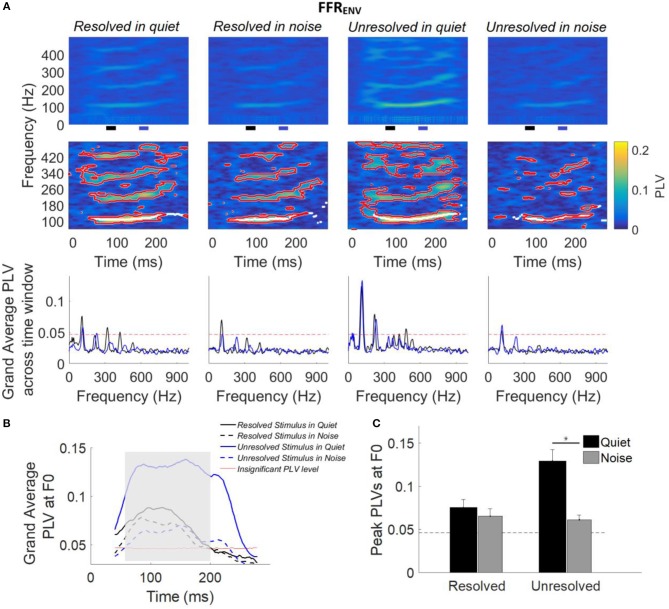
(A) Grand average FFRENV PLVs (top panels) and FFRENV PLVs from a representative participant (middle panels) as a function of time and frequency for each condition. In the middle panel, PLVs that were significantly higher than the bootstrapped noise distribution are enclosed by red lines, and PLV curves at F0 (the maximum PLV at each time point) are shown in white lines. The horizontal axis represents the midpoint of the 80 ms analysis window, the vertical axis represents the frequency, and the color represents the PLV at each time and frequency (yellow is largest). The grand average FFRENV PLV across participants (bottom panel) as a function of response frequency at two different time slides. The black and blue line represents the averaged PLV from 80 to 100 ms (black bar) and from 160 to 170 ms (blue bar). The black and blue bar showed in the bottom of the top panel. (B) Grand average PLV curves at F0 for each stimulus condition. Responses above the red line are significant (p < 0.01). The shaded area represents when PLV is significant at F0 for all four conditions. The time represents the midpoint of the 80 ms time window. (C) Peak PLV at F0 averaged across participants for each stimulus condition. Error bars represent one standard error. Responses above the dashed back line are significant (p < 0.01). The significant difference of p < 0.001 is indicated by the asterisk.